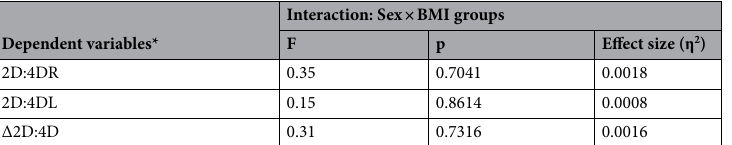
Table 3. Results of general linear model (GLM) of the significance assessor of interaction between sex and BMI groups for 2D:4D and Δ2D:4D variability. *Adjusted to age after Box-Cox transformation, body height, sex, and groups of BMI : normal, overweight, obesity. F, test F; p, probability; η 2 , eta